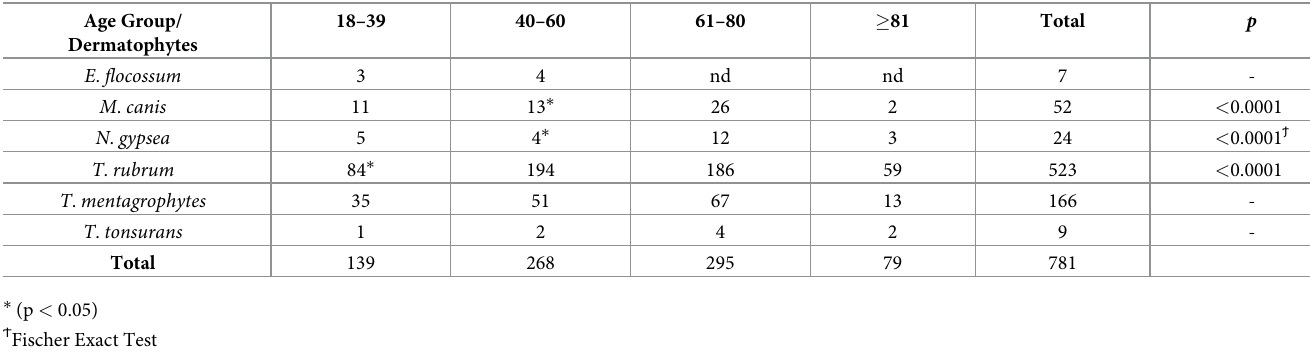
Table 4. Distribution of dermatophytes according to the age group of the diseased investigated population. Age Group/